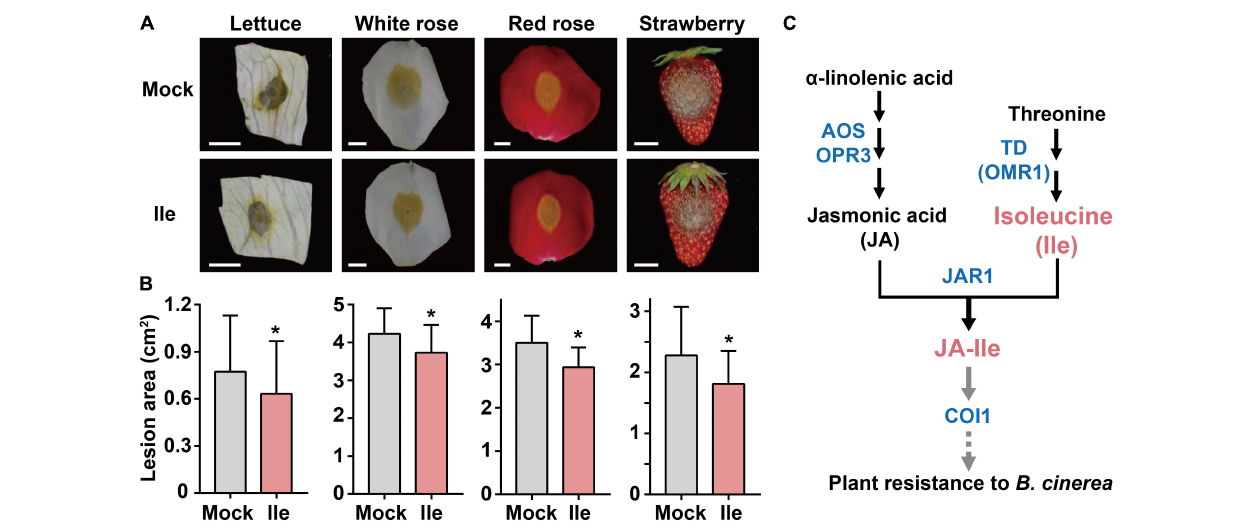
FIGURE 5 | Application of Ile improves plant resistance to B. cinerea in horticultural plants. (A,B) Representative phenotype (A) and lesion area (B) of lettuce, roses, and strawberry after B. cinerea infection. 10 mM Ile and 0.05% Tween 20 solution (Mock) were respectively sprayed on lettuce leaves, flowers (white rose and red rose), and strawberries for 2 days before inoculation. Then, the detached indicated parts of plants were inoculated with B. cinerea spores suspension (1.0 × 10 6 spores/ml), moisturized in 1% agar dishes, and incubated in the dark for indicated days. Lesion sizes were measured and analyzed after 2 days for white rose ( n = 57–58), 3 days for lettuce ( n = 54–57) and red rose ( n = 24–26), and 4 days for strawberry ( n = 32). Scale: 1 cm. Data are means ± SD. Asterisks indicate significant differences compared with Mock treatment (Student’s t -test, * p < 0.05). (C) Regulation model of B. cinerea resistance mediated by Ile through JA signaling. JA is synthesized from α -linolenic acid through serial key enzymes, such as Allene oxide synthase (AOS) and OPDA reductase 3 (OPR3). Threonine deaminase (OMR1) catalyzes the conversion of threonine into 2-oxobutanoate, which is the first and the committed step in Ile biosynthesis. JA-Ile is then synthesized by conjugating jasmonic acid (JA) with Ile via JA-amido synthetase JAR1. On B. cinerea infection, a high Ile level will contribute to stronger induction of JA-Ile biosynthesis and then lead to enhanced JA responses depending on JAR1 and COI1. Black arrows represent the schematic diagram of JA-Ile biosynthesis. Gray arrows represent that JA-Ile is recognized by receptor COI1, subsequentially activating signal transduction to defense against B. cinerea